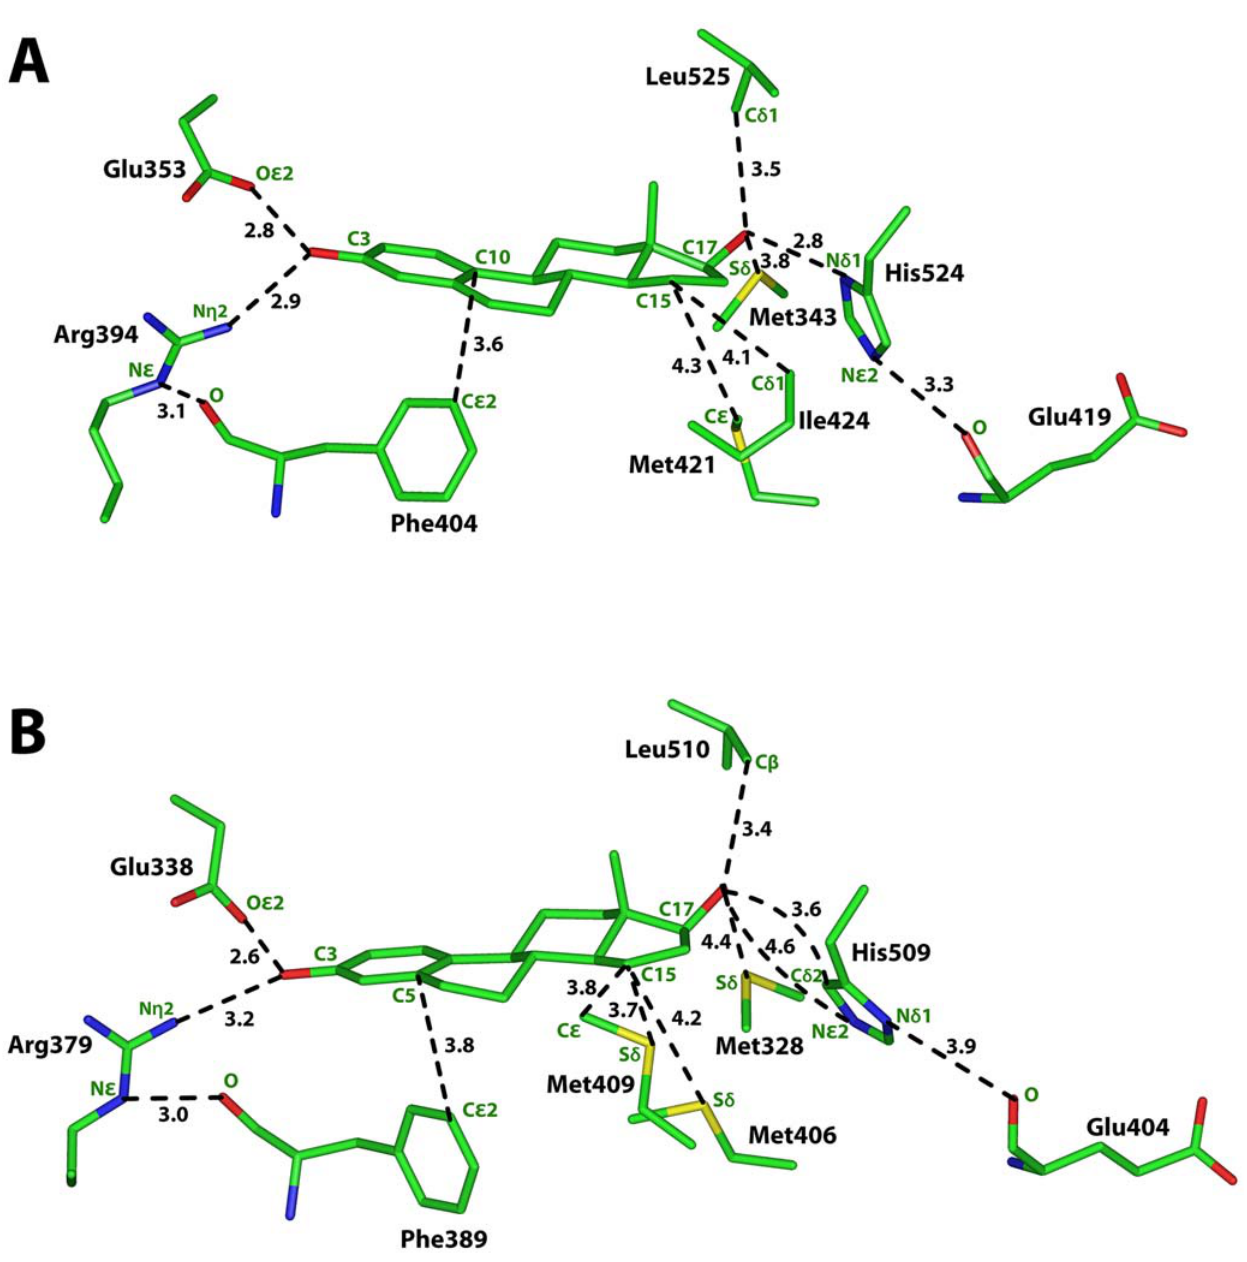
Figure 4. Interaction of E2 with human ER a and the 3D model lamprey ER. A. Interaction between E2 and human ER a . B. Interaction between E2 and the 3D model of lamprey ER. Lamprey ER has stabilizing interactions with the A ring of E2 similar to those in human ER a . His-509 has rotated and does not have a hydrogen bond with the C17-hydroxyl on E2. Instead, C d 2 has a van der Waals contact with the C17-hydroxyl on E2. Also, C e and S d on Met-409 have stabilizing contacts with C15 on